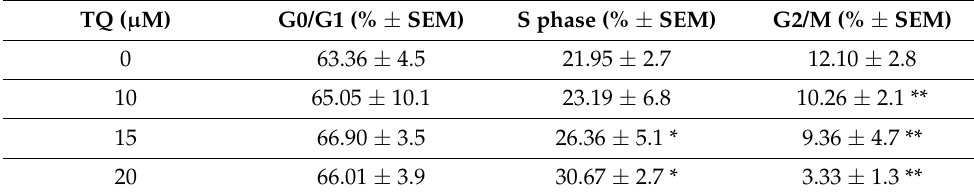
Table 1. The mean distribution of cell cycle phases in TQ treated.